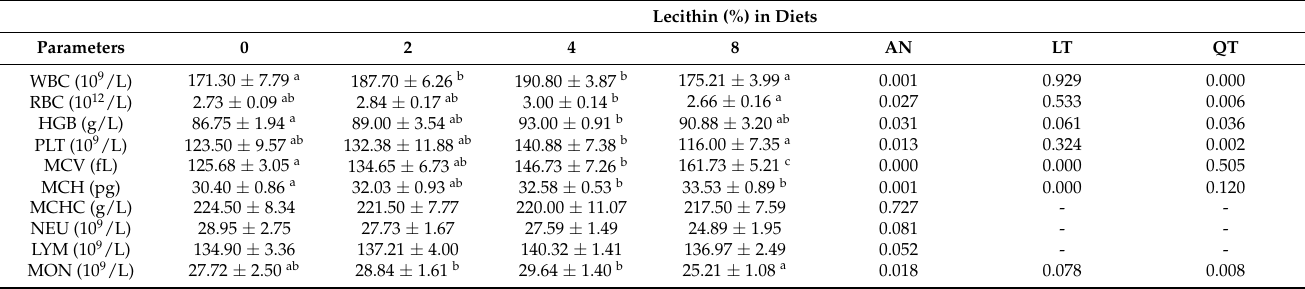
Figure 1. E ff ect of dietary soybean lecithin on weight gain (%) ( A ) and daily growth rate (%) ( B ) of Note: a–c Values in the same row with different letters indicate significant differences ( p < 0.05), while that with juvenile largemouth bass. Bars with di ff erent le tt ers indicate signi fi cant di ff erences ( p < 0.05), while the same letter or no letter superscripts indicate no significant differences ( p > 0.05). AN: ANOVA, LT: linear trend, that with the same le tt er or no le tt er superscripts indicate no signi fi cant di ff erences ( p > 0.05), AN: QT: quadratic trend. ANOVA, LT: linear trend, QT: quadratic trend.